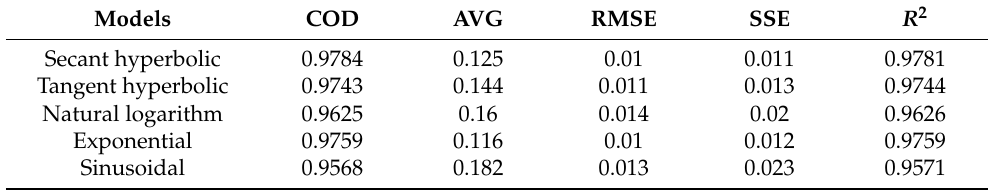
Table 5. Precision and performance of the models for ∆ H prediction (training data).